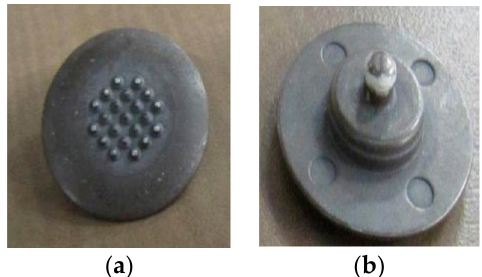
Figure 3. ( a ) Orbital electrode (electrode’s kin side); ( b ) Orbital electrode (electrode’s snap side).